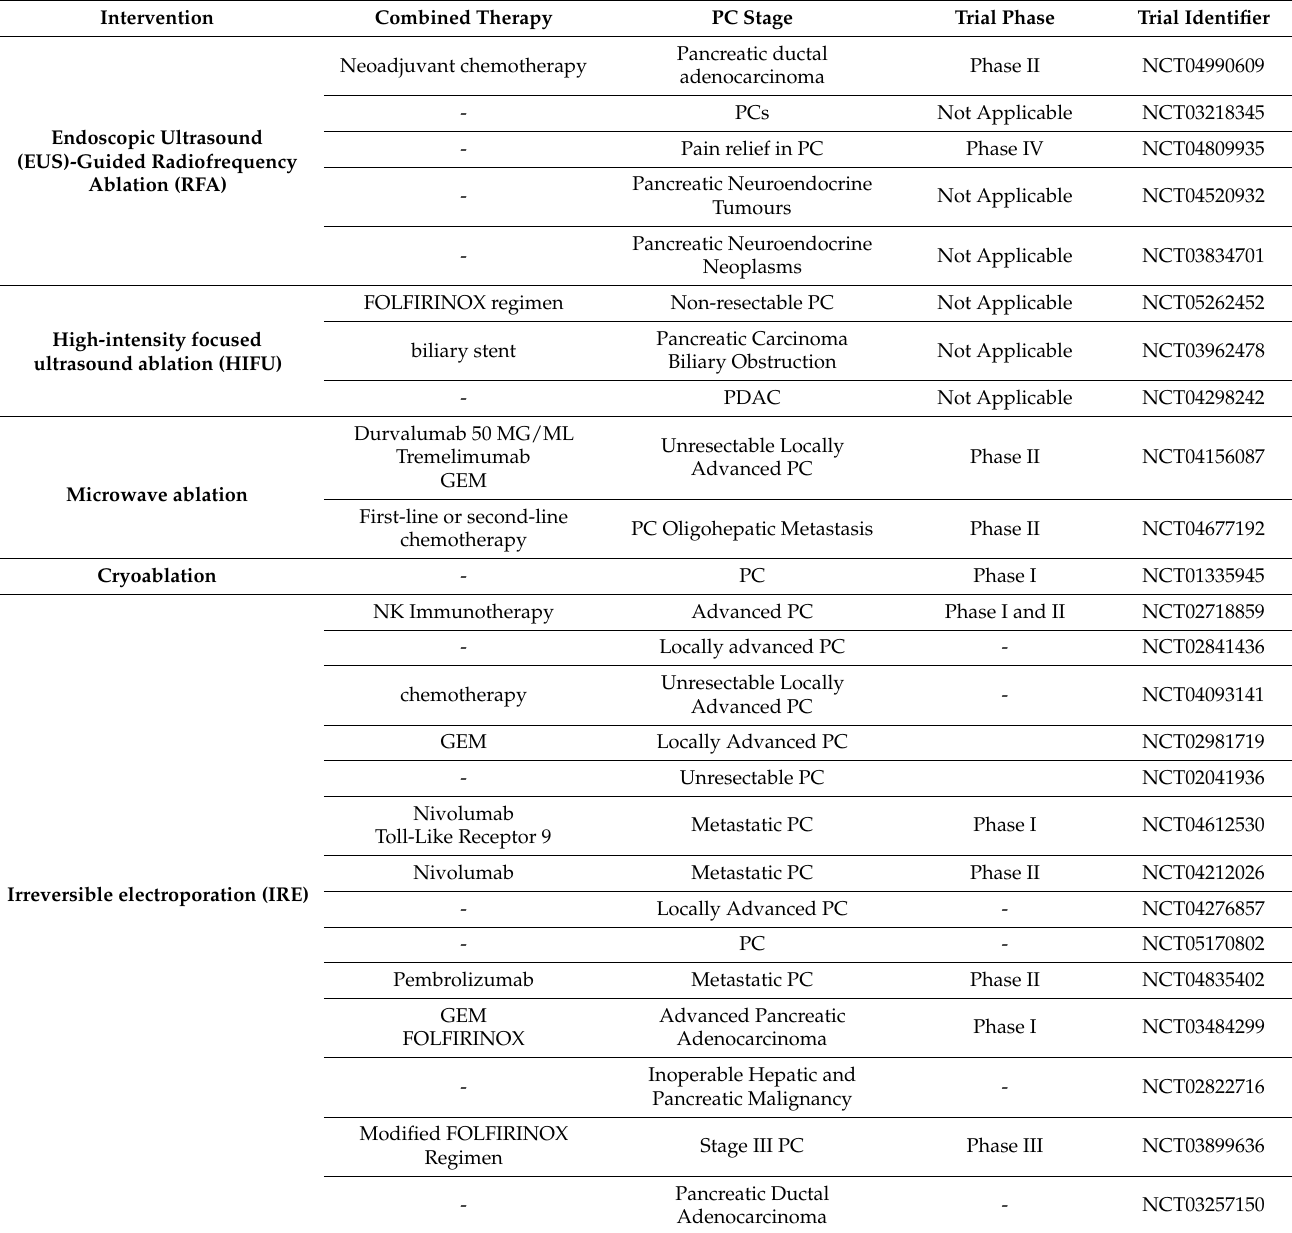
Table 4. List of locoregional therapies in clinical trials. Information was obtained from clinicaltrials. gov